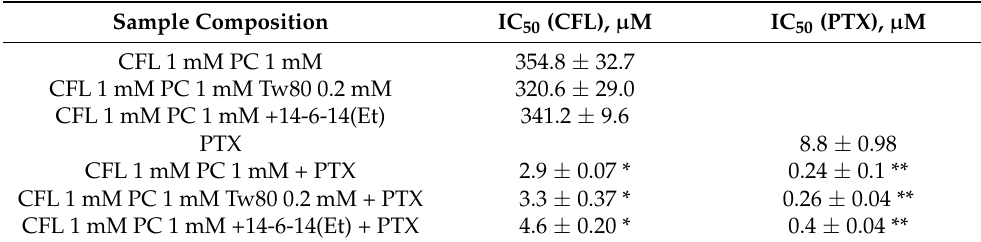
Table 3. Cytotoxicity of hybrid cerasomes with different compositions, free PTX and PTX formulated in cerasomes toward T98G glioma cell line evaluated by 24 h MTT test. Sample Composition